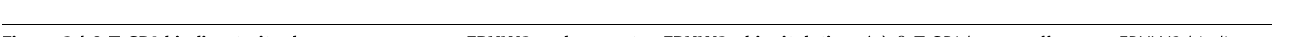
GRK2 kinase, appears to mediate FBXW2 phosphorylation at the b -TrCP binding motif.